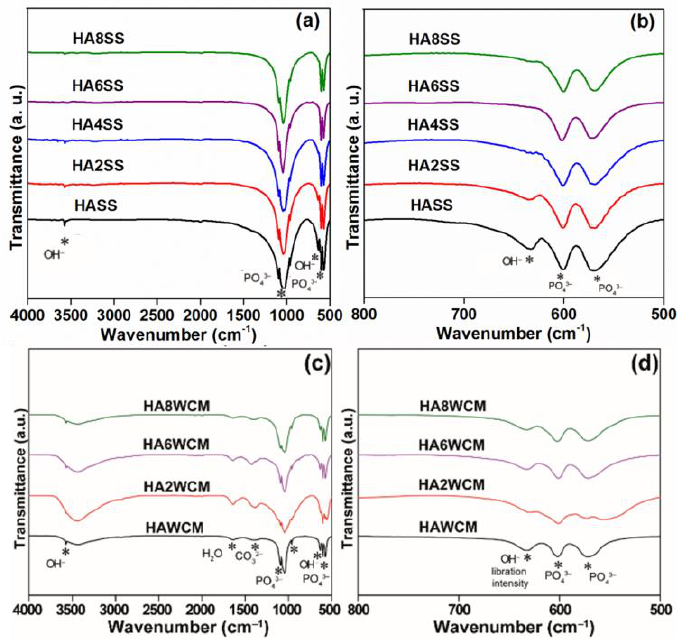
Figure 5. Fourier transform infrared (FTIR) spectra covering the ranges of 4000 – 500 cm −1 ( a , c ) and 800 – 500 cm −1 ( b , d ) for the solid-state synthesised apatites ( top ) and the wet chemical derived products ( bottom ).